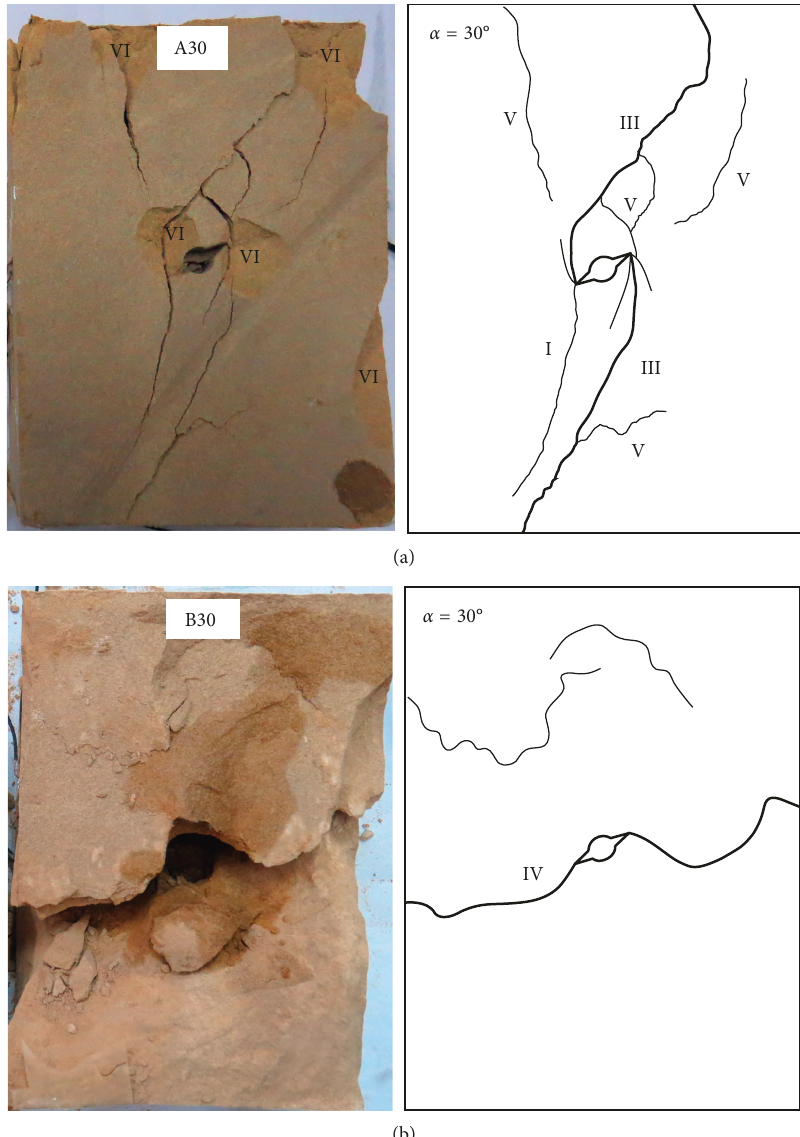
Figure 7: Effect of seepage pressure on ultimate failure modes of sandstone specimens containing fissure angle α pressure. (b) With seepage